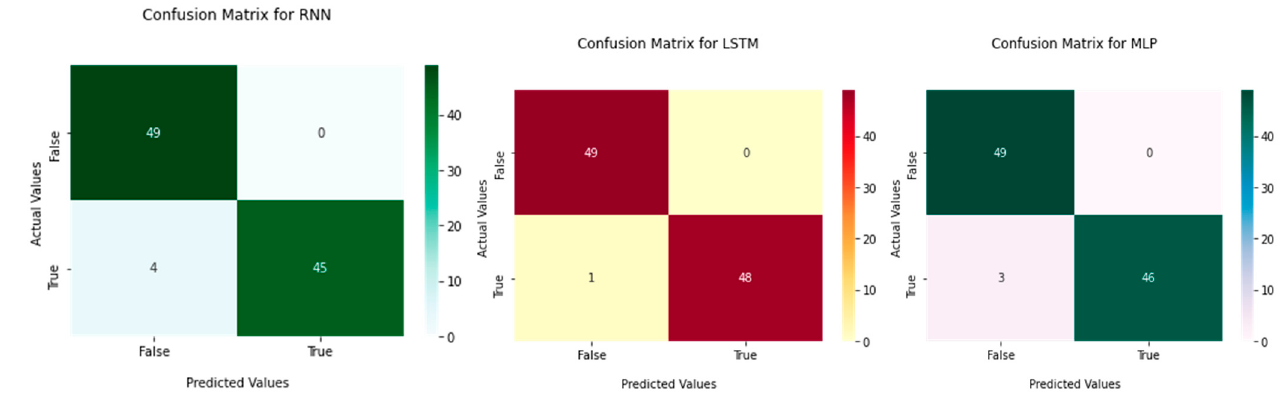
Figure 5. Confusion matrix outcomes for three deep learning models.